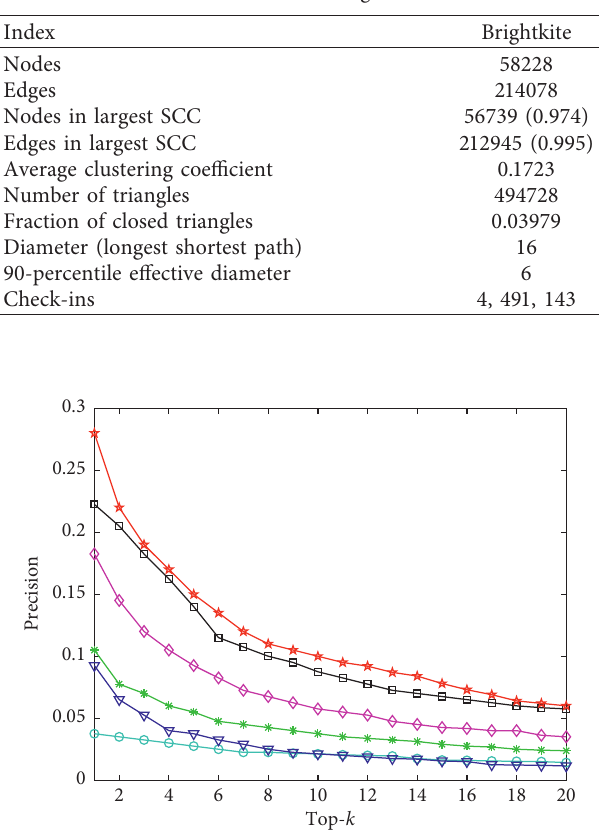
Table 1: Statistics of the Brightkite dataset.